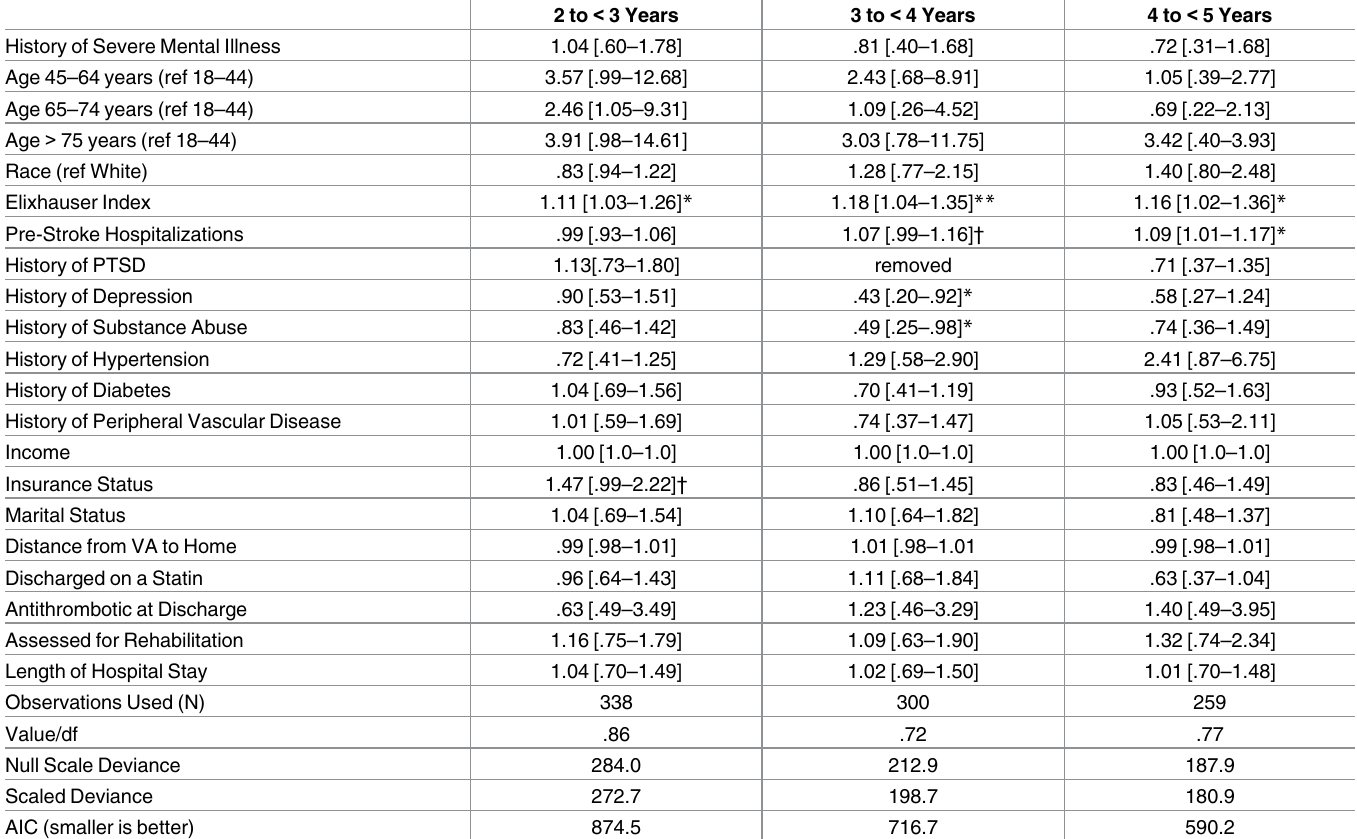
Table 5. Poisson multiple regression assessingthe association of SMI with non-psychiatric hospitalization over time-intervals from 2-years through